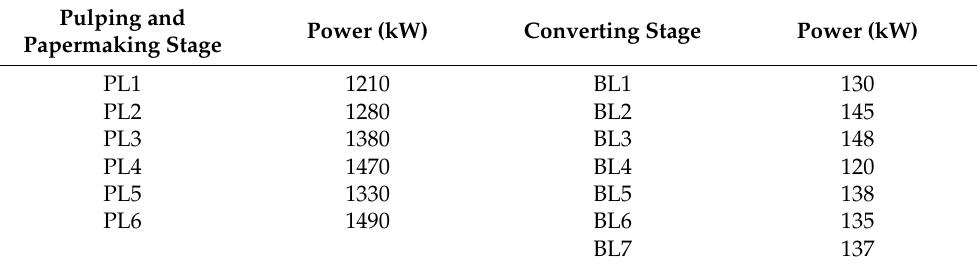
Table 4. The maximum power of the production line in the pulping and papermaking stage and the converting stage.